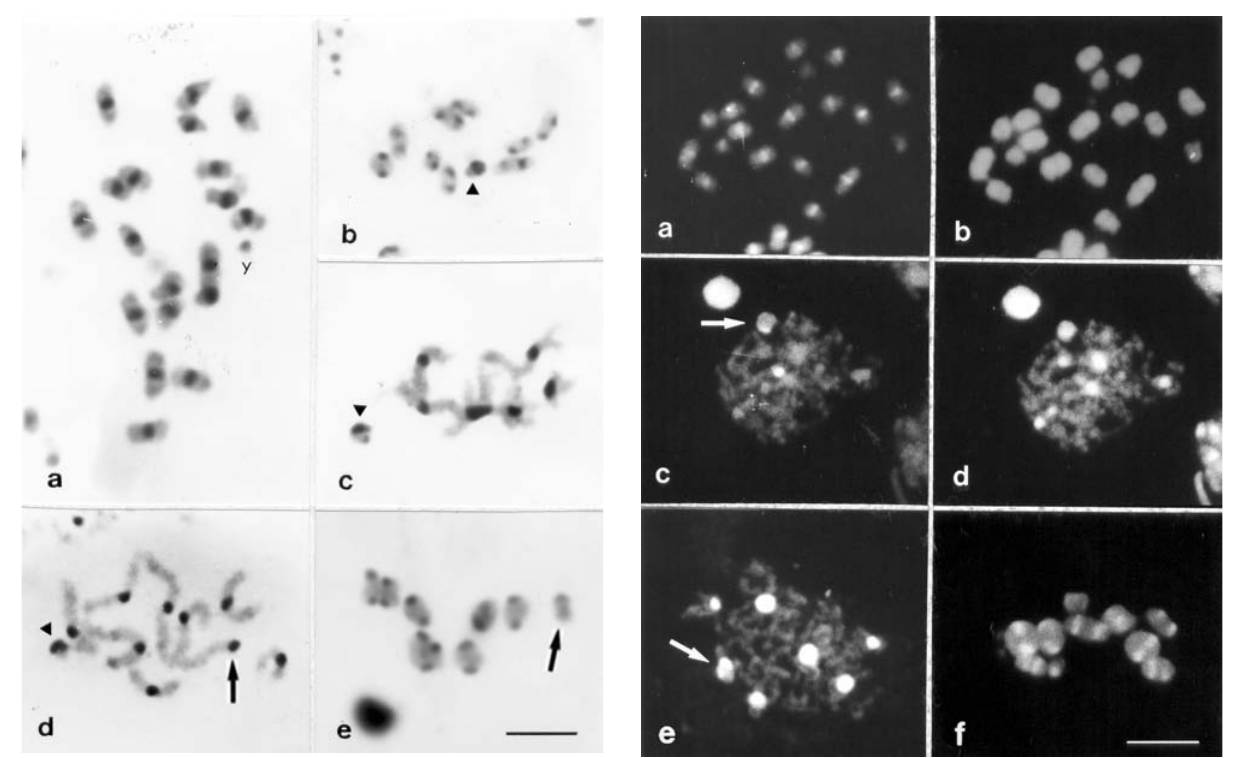
Figure 3 - CMA 3 /DA/DAPI staining in G. borelli (a, b) and P. pallidipennis (c, d), and double CMA 3 /DA staining in S. s. hirtus (e, f). (a, b) Incomplete spermatogonial metaphase (a,b) showing pericentromeric CMA 3 + blocks. Initial zygotene (c, d). Note the CMA 3 + blocks in the sex pair (arrow) and in an autosomal bivalent (d). Note the associated DAPI+ constitutive heterochromatin blocks. (e, f) pachytene and metaphase I. The arrows in (c-e) indicate the Xy p bivalent. Bar = 5 (cid:1)